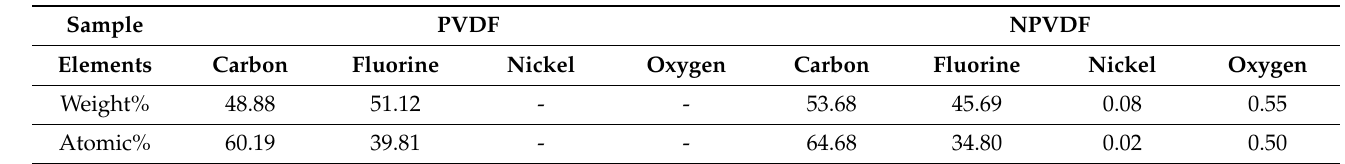
Figure 3. EDX mapping of ( a ) a random portion of the NPVDF film showing the existence of the desired elements such as ( b ) carbon, ( c ) fluorine, ( d ) nickel, and ( e ) oxygen. Table 1. Amounts of desired elements within the PVDF and NPVDF films as observed from the EDX characterization.